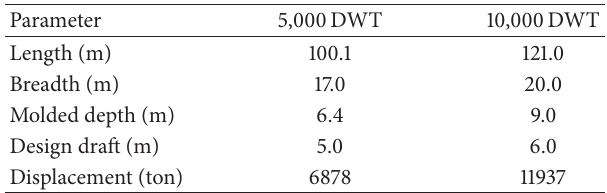
Table 1: Basic parameters of the two